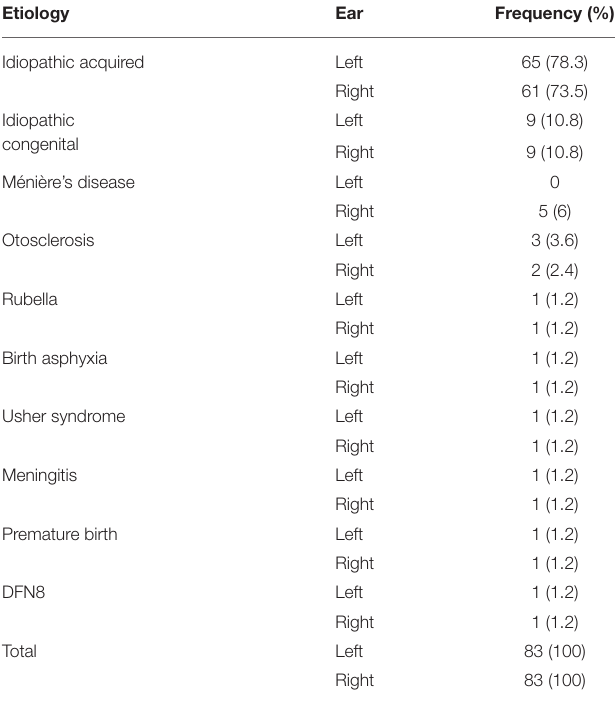
TABLE 1 | Etiology of hearing loss per ear.